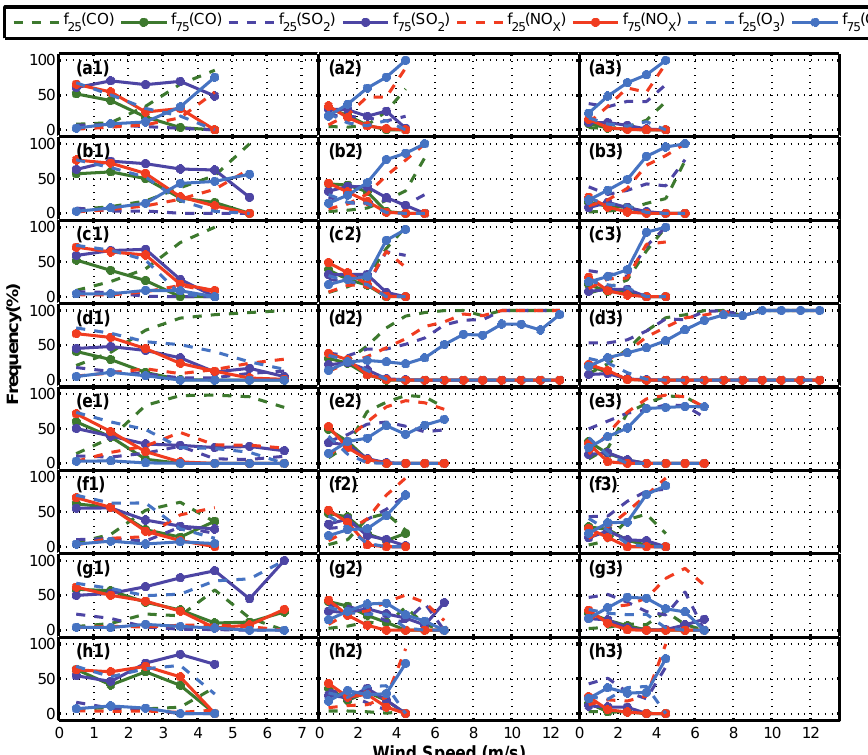
Fig. 8. Variation of frequency( f 25 and f 75 ) with wind speed (WS) and wind direction (WD). (a–h) represent S, SW, W, NW, N, NE, E, SE, respectively, while (1–3) stand for summer, fall and winter. Calculation methods are given in Sect.